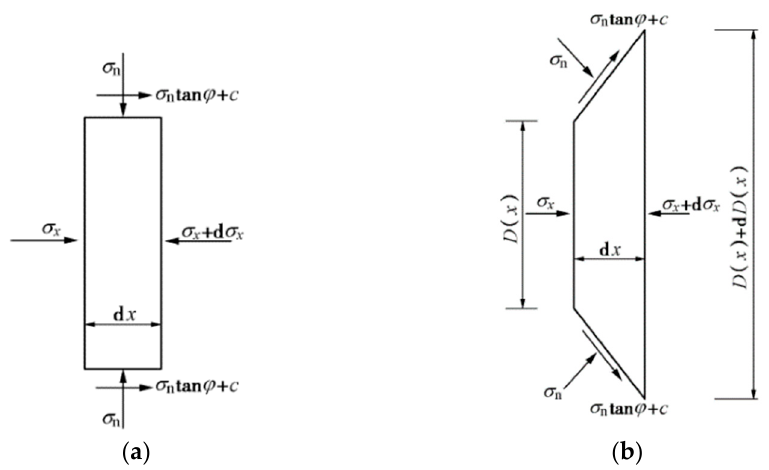
Figure 5. Stress analysis of a micro-unit in the plastic zone. ( a ) Zone AA E E ′ ′ ; ( b ) zone EE B B ′ ′ .